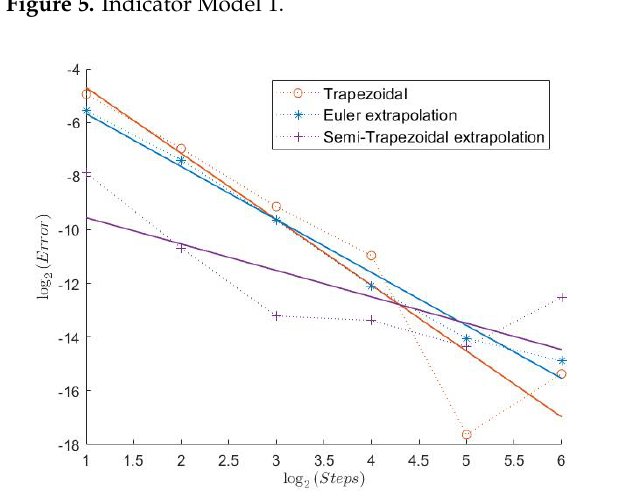
Figure 5. Indicator Model 1.